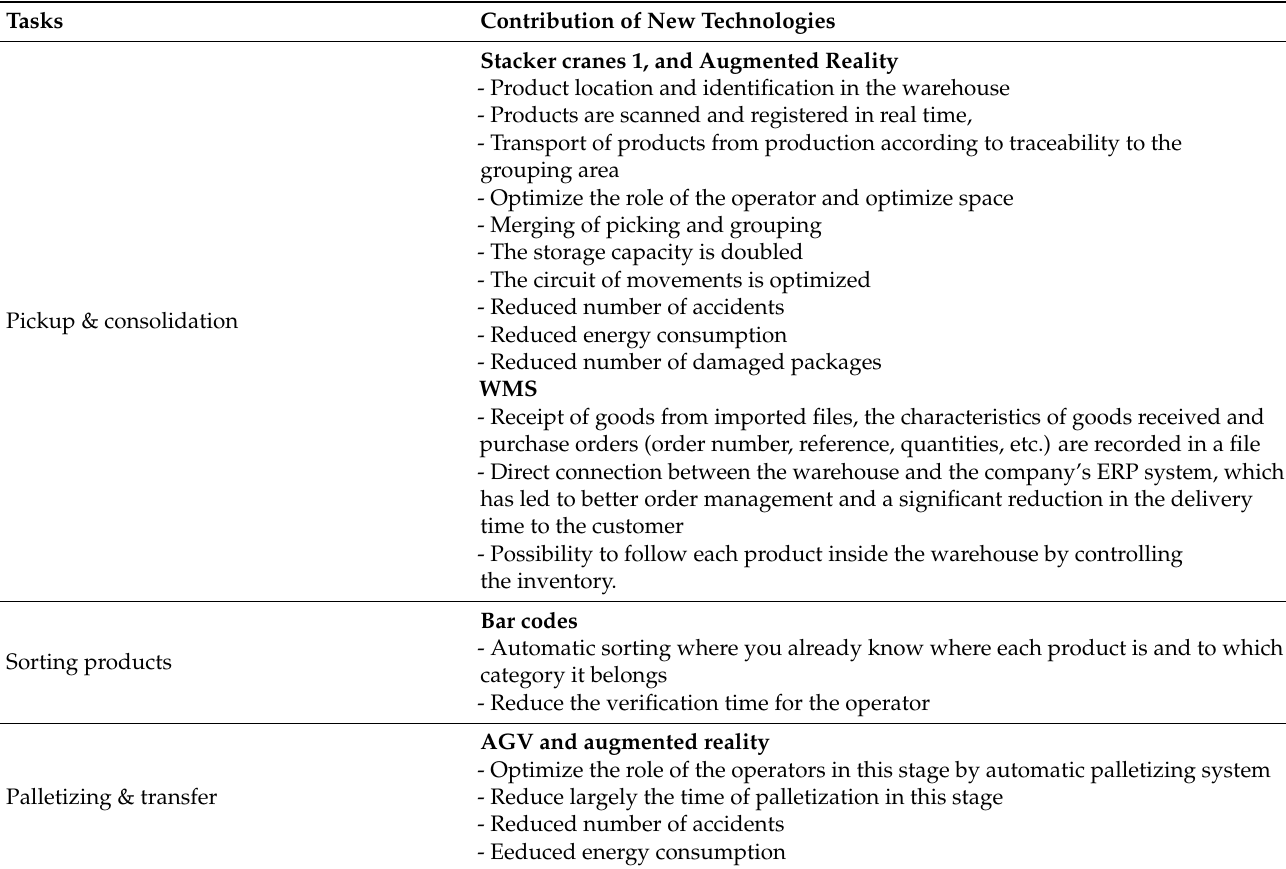
Table 5. Contribution of technologies for each